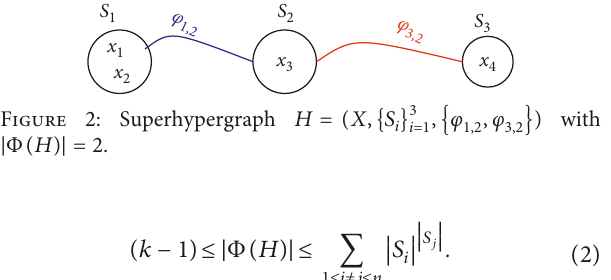
, φ , φ , φ , φ 􏼈 􏼉 4 􏽮 􏽯 ) . i i � 1 1 , 2 2 , 1 2 , 3 2 , 4